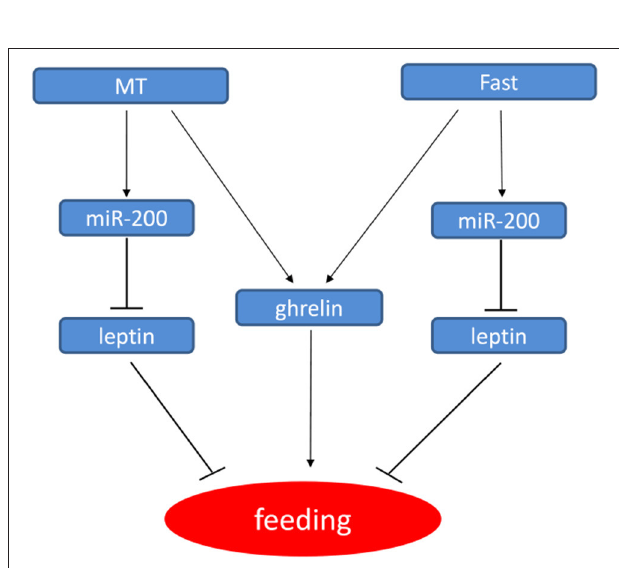
FIGURE 7 | Model for the regulatory networks of feeding in yellow catfish involved miR-200/leptin. In yellow catfish juvenile, miR-200 regulate feeding by directly repressing leptin gene. Further, miR-200 and ghrelin genes are up-regulated by MT and fast treatment, thereby resulting in the down-regulation of leptin and leptin receptor, thus forming a regulatory